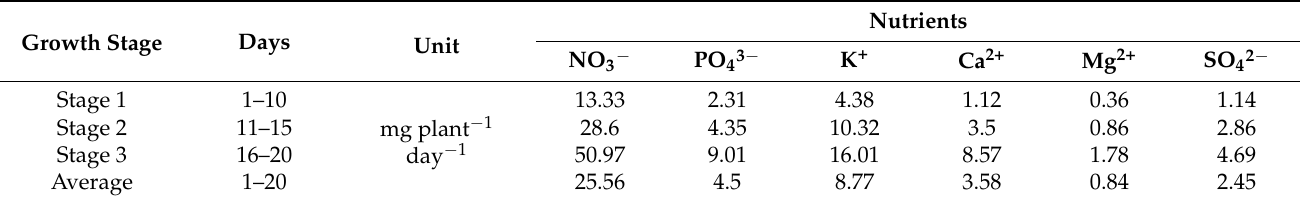
Table 2. Daily absorption of NO 3 − , PO 4 3 − , K + , Ca 2+ , Mg 2+ , and SO 4 2 − by basil plants at 1–10, 11–15,